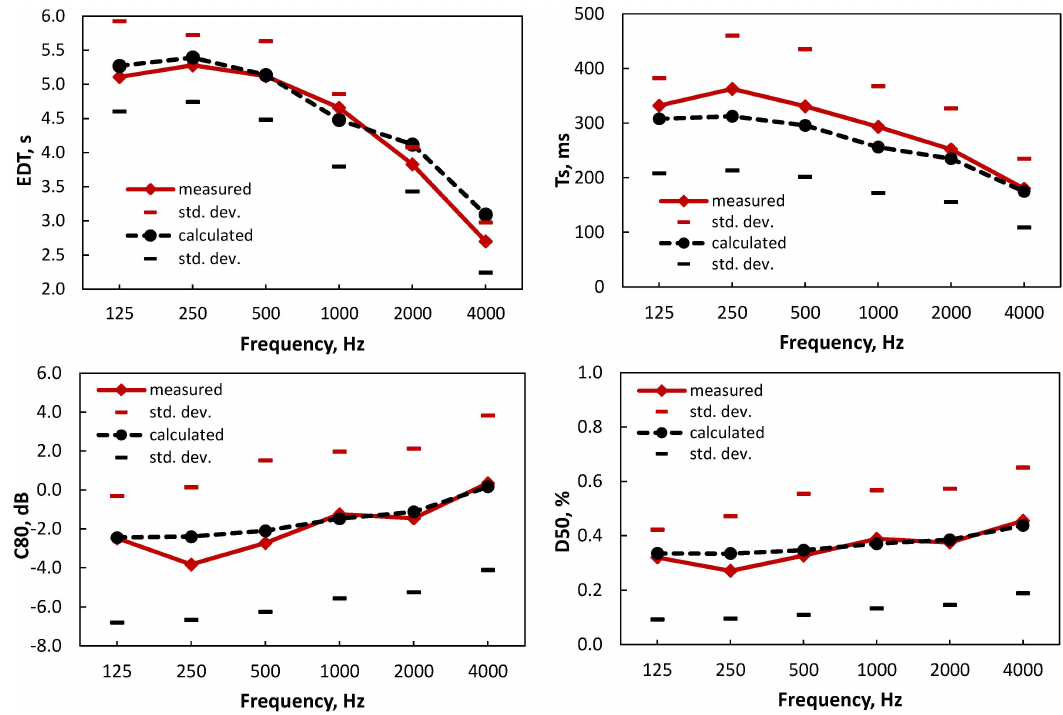
Figure 4. Comparison between measured and simulated results averaged among the 15 receiver positions of four room acoustic parameters, EDT, T s , C 80 , and D 50 , and their standard